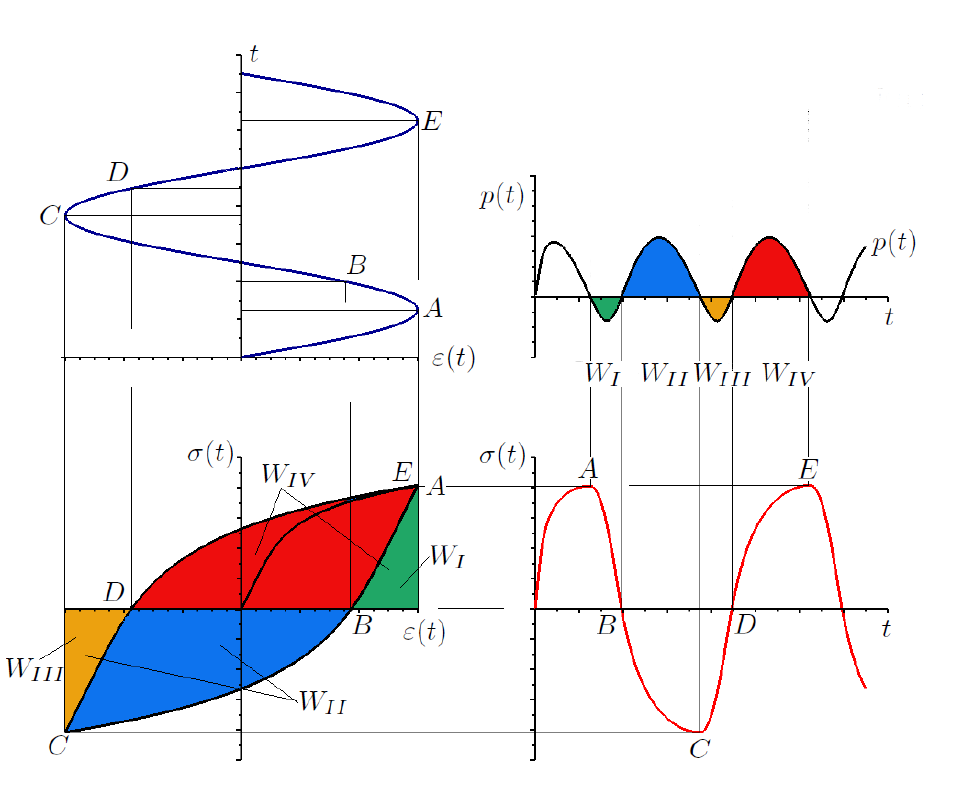
Figure 8. Method of calculating the elastic–plastic strain energy density by integrating the time course of instantaneous